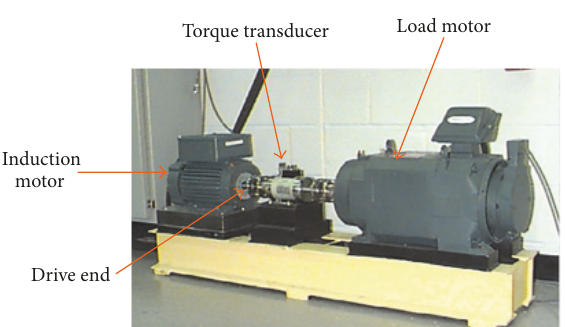
Figure 12: Rolling bearing fault simulation platform.